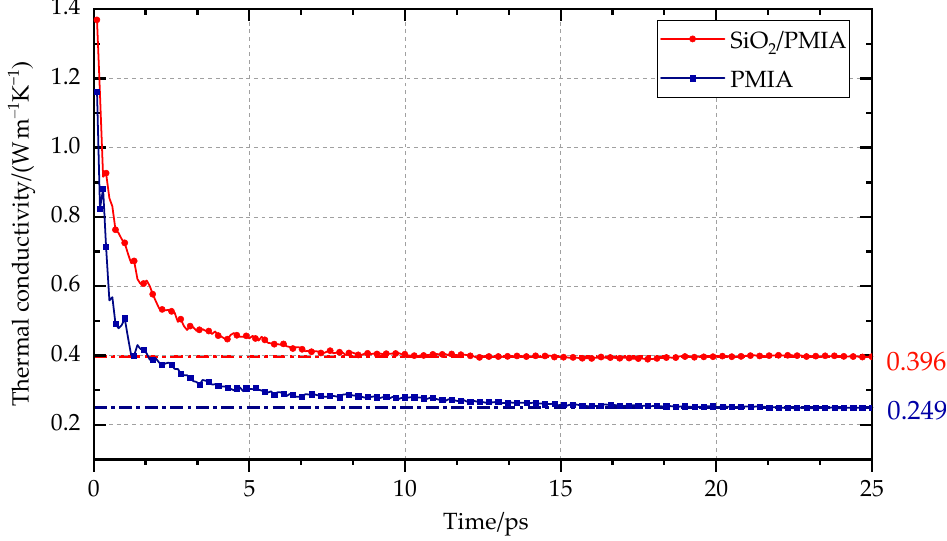
Figure 3. Thermal conductivity simulation results.